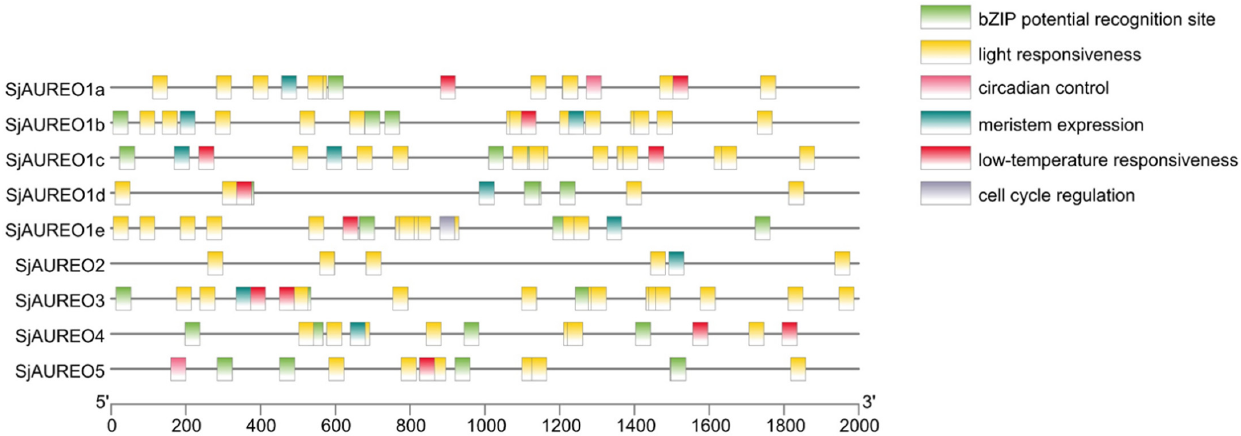
Figure 4. The six key cis-acting elements predicted in the upstream gene region of Sj AUREO.